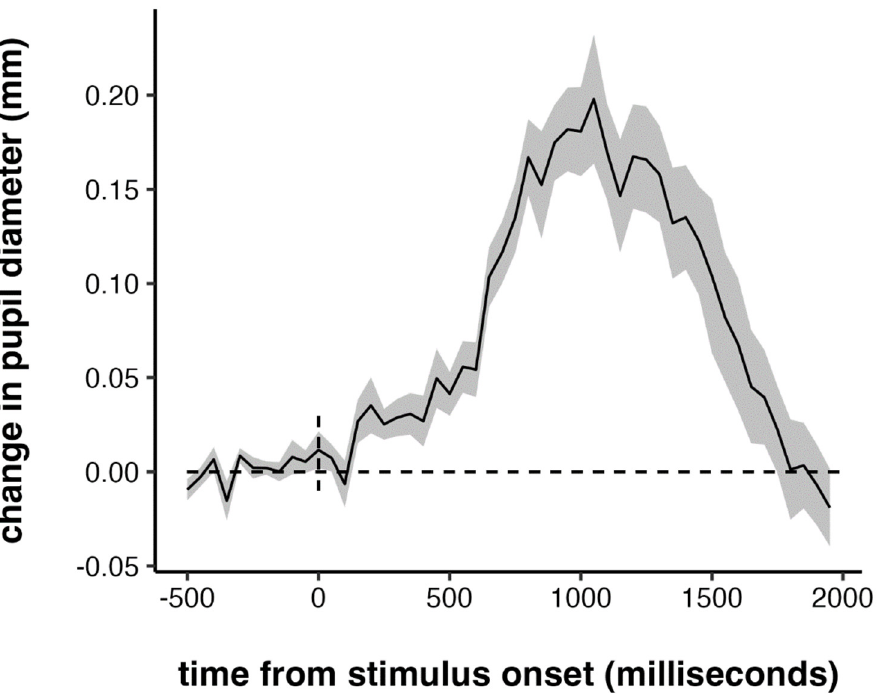
Figure 3. Grand-averaged task-evoked pupillary response. Shaded error bar represents +/ − one standard error.